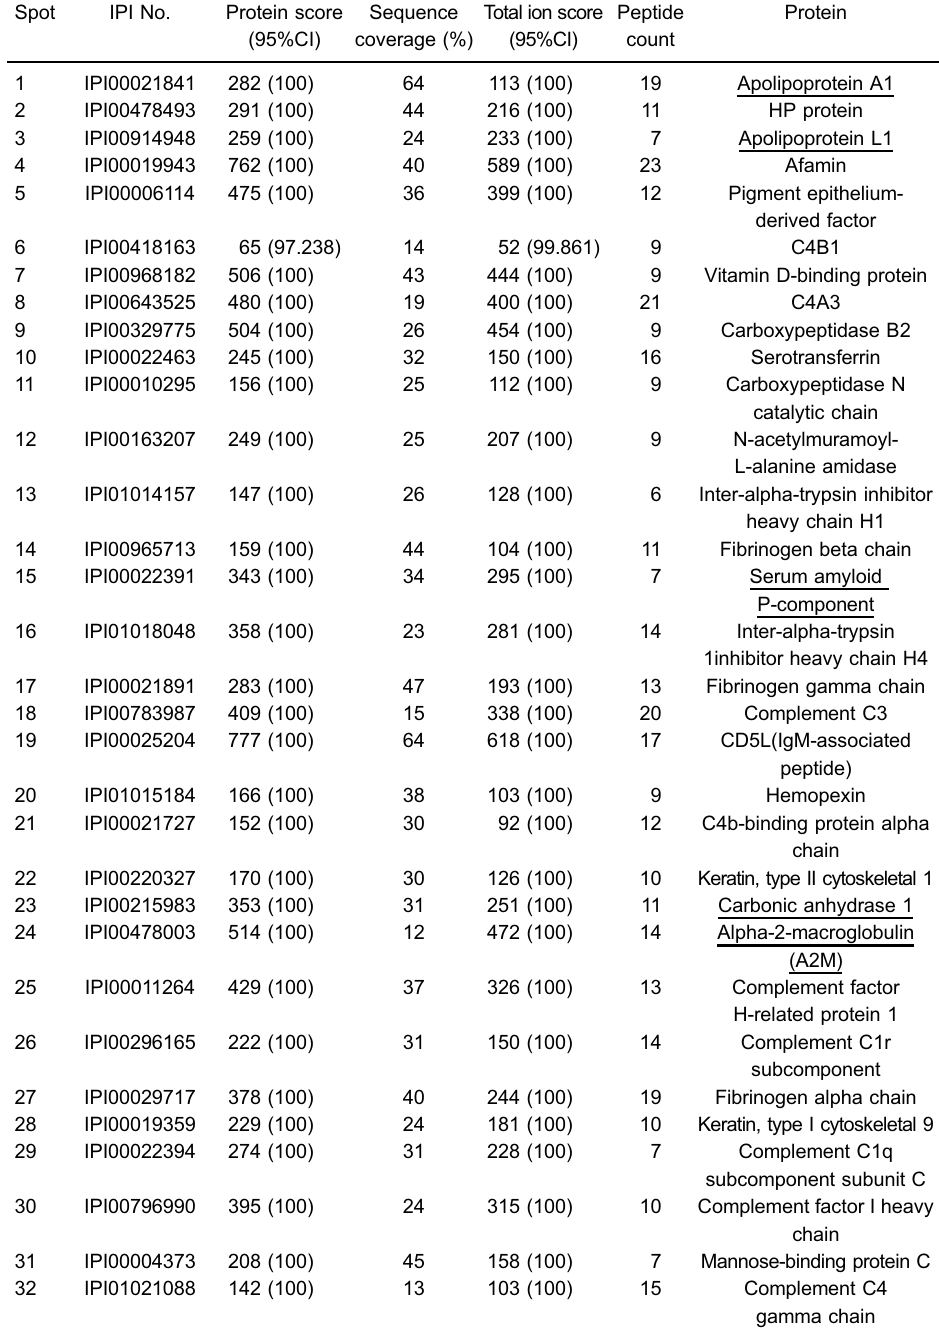
Table 2. Mass spectrometry data for differentially expressed